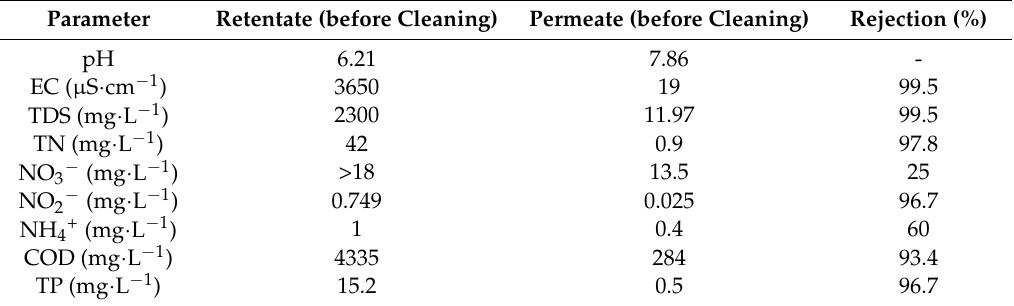
Table 3. Retentate and permeate quality of the hydrophilic-coated hydrophobic PTFE membrane.